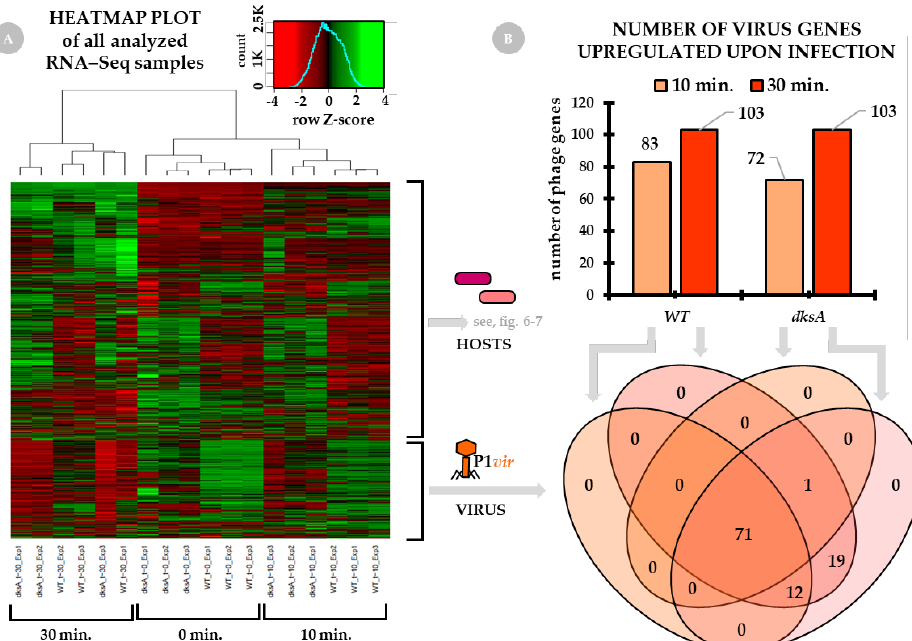
Figure 1. Changes in global gene expression in the course of the virus-host interactions. The wild type and the dksA mutant cultures were infected with the P1 vir phage at the beginning of the logarithmic phase of growth. Total RNA sequencing (RNA-seq) was performed for three post-infection time-points: 0 min (no-phage control), 10 min (early gene expression), and 30 min (late gene expression). Panel ( A ) presents the heatmap plot of all analyzed RNA-seq samples based on the expression of all detected genes of both hosts (wild type and dksA mutant) and the P1 vir virus. Sample replicates (three for each condition) are listed below the heatmap. Gene expression data are presented as Z-score transformed, scaled in rows values. Panel ( B ) shows the number of P1 vir phage genes which have been expressed at 10 and 30 min of infection. The Venn diagram below panel B shows the number of P1 vir genes upregulated in the wild type and dksA mutant cells.